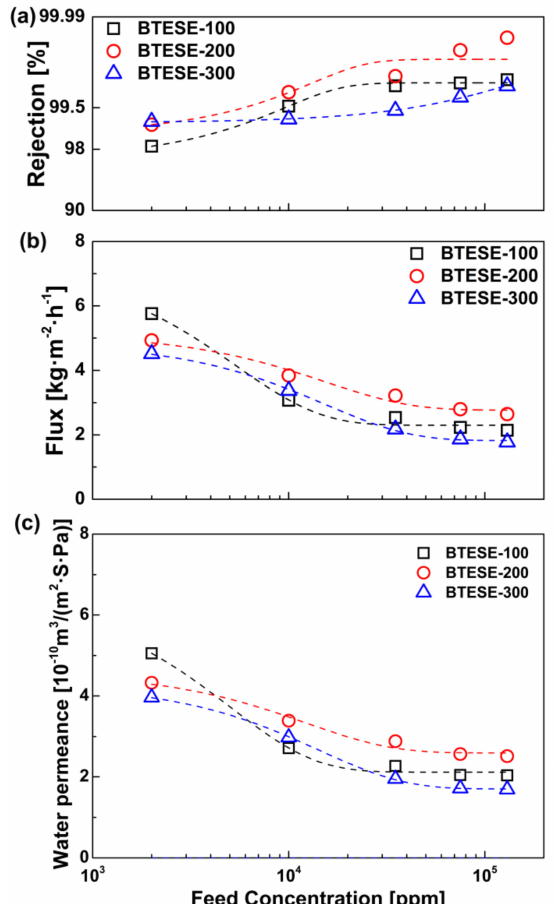
Figure 5. E ff ect of feed concentration on ( a ) NaCl rejection, ( b ) water flux, and ( c ) water permeance of the BTESE membranes at 25 ◦